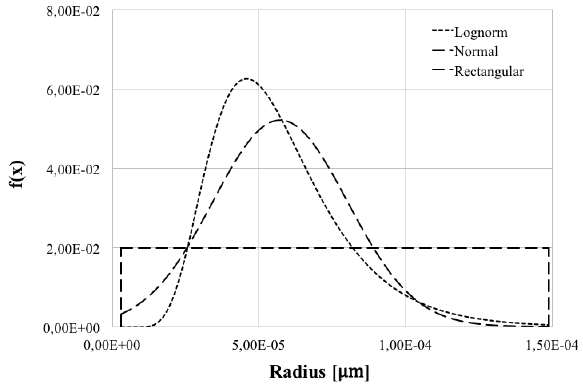
Figure 1: Initial grain size distribution A simulation of an annealing process of 300 seconds at T=1100 ∘ C resulted in a mean grain radius obtained from the uniform distribution bigger than the log-normal and normal distribution (respectively 29.25% bigger and 43.74%) and the difference for the three trends begin after the complete recrystallization of steel as can be seen in fig- ure 2. The difference between the-log normal and normal distribution is less pronounced and the log-normal distri- bution leads to a 20 % larger grain.